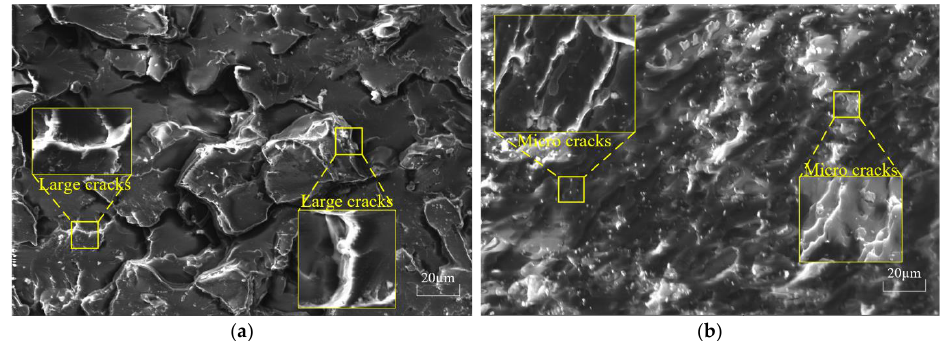
Figure 5. SEM diagram of tensile section of resin before and after adding filler: ( a ) Pure resin; ( b ) Resin after adding filler.